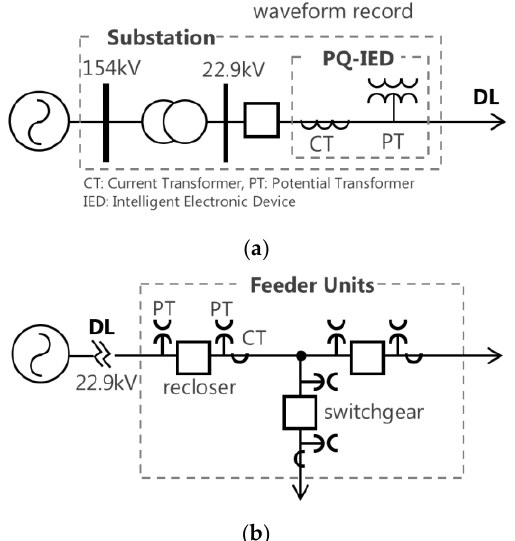
Figure 2. On-field waveform acquisition devices (sensors). ( a ) A DL measuring unit location; ( b ) Feeder remote terminal unit allocations on DLs.